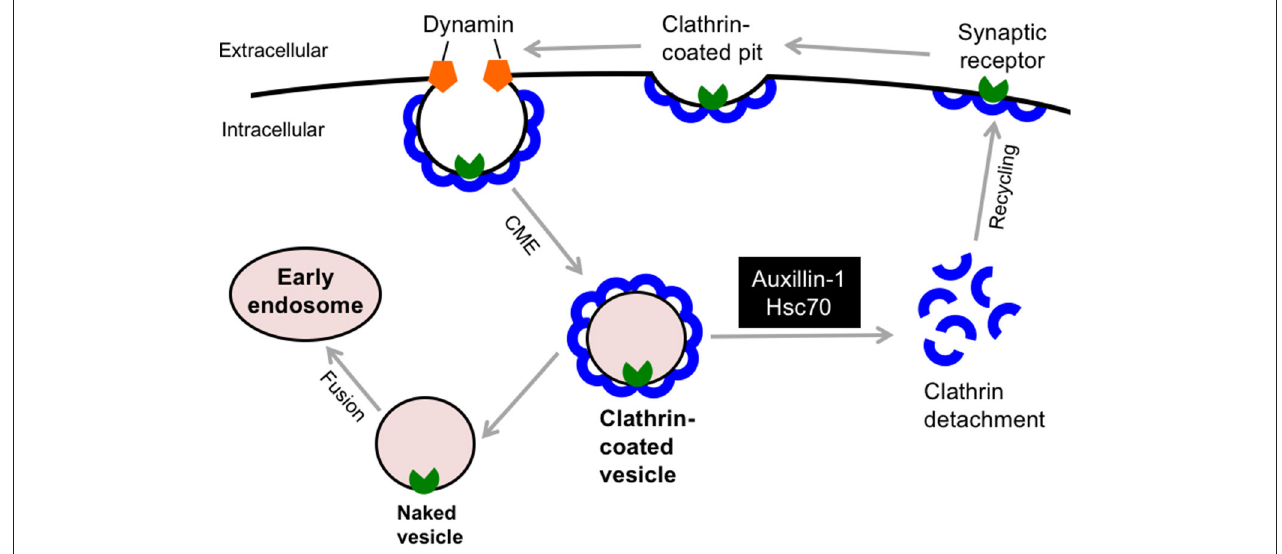
FIGURE 4 | DNAJC6/Auxilin-1 regulates the clathrin-mediated endocytosis. DNAJC6/Auxilin-1 is highly expressed in nerve terminals and plays a crucial role in clathrin uncoating during synaptic receptor endocytosis. CME, clathrin-mediated endocytosis; Hsc70, heat shock cognate